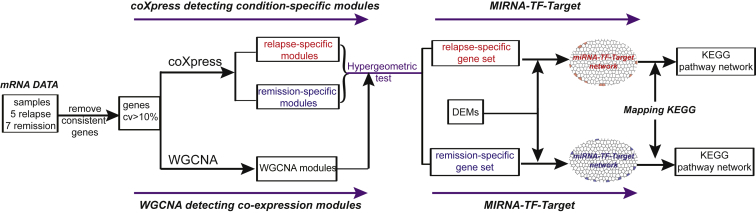
The Workflow for Co-expression and miRNA-TF-Gene Network Analyses